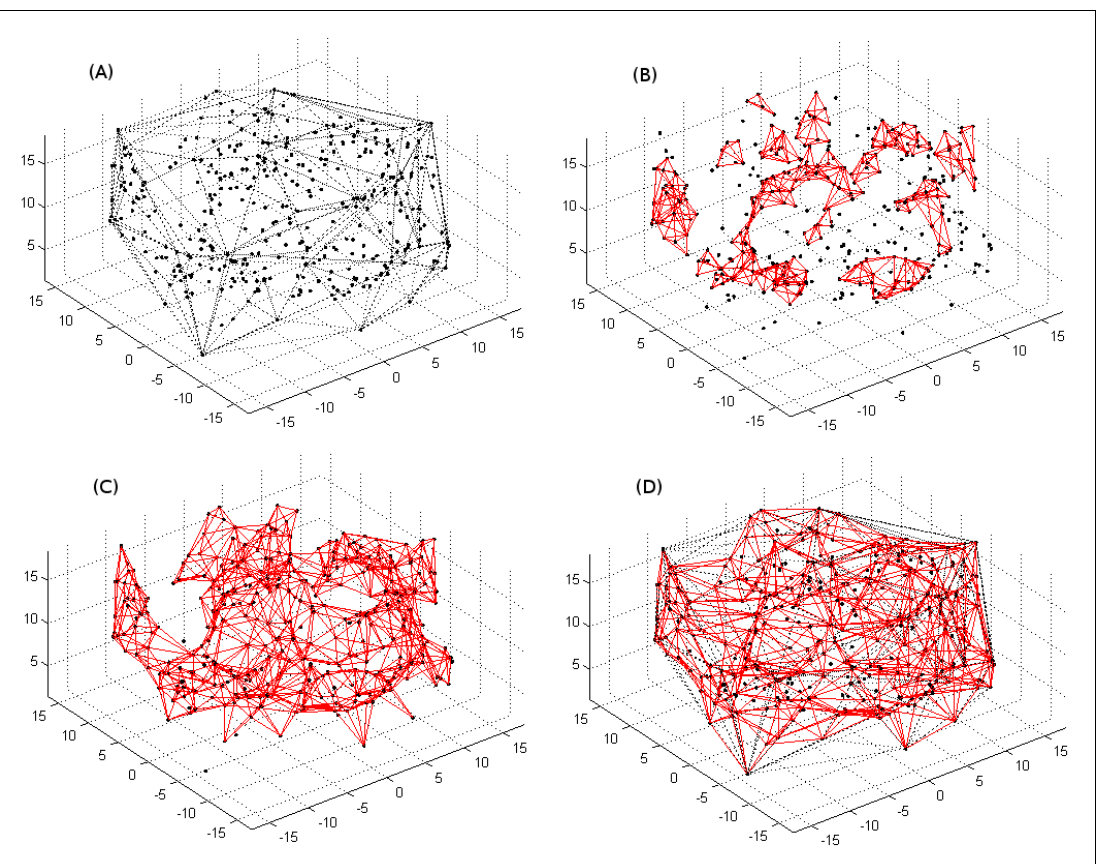
Figure 1. Triangulation and filtration of an example set of 3D points illustrated with symbols corresponding to Section 2.3. Subplot (A) shows the extreme values of the filtration: the initial set of points (i=0, F[0]=0, C 0 = ∅ , and V C,0 =0 m 3 ) and the convex hull of the point data (i=s=2081, F[2081]=∞, C 2081 =all, and V C,2081 =11343.6 m 3 ) denoted by dashed lines. The red lines in subplots B, C, and D correspond to subcomplexes with F[214]=3.5m and V C,214 =206.7 m 3 , F[746]=7.2m and V C,746 =1379.1 m 3 , and F[1477]=18.7 m and V C,1477 =5206.5 m 3 ,